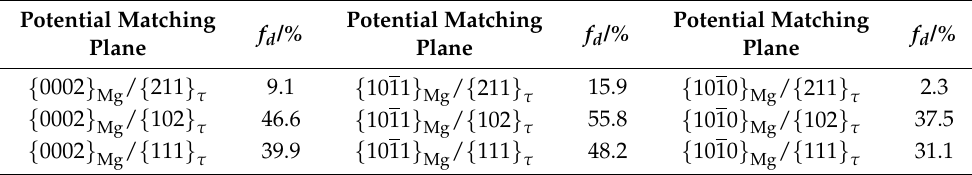
Table 2. The matching plane pairs between α -Mg and CaMgSn.